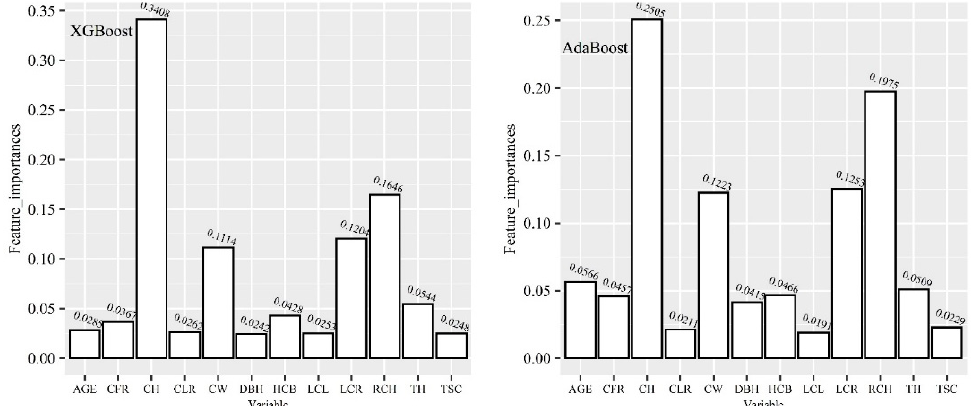
Figure 3. Feature importance for the four ensemble learning models (RF, GBDT, XGBoost and AdaBoost).